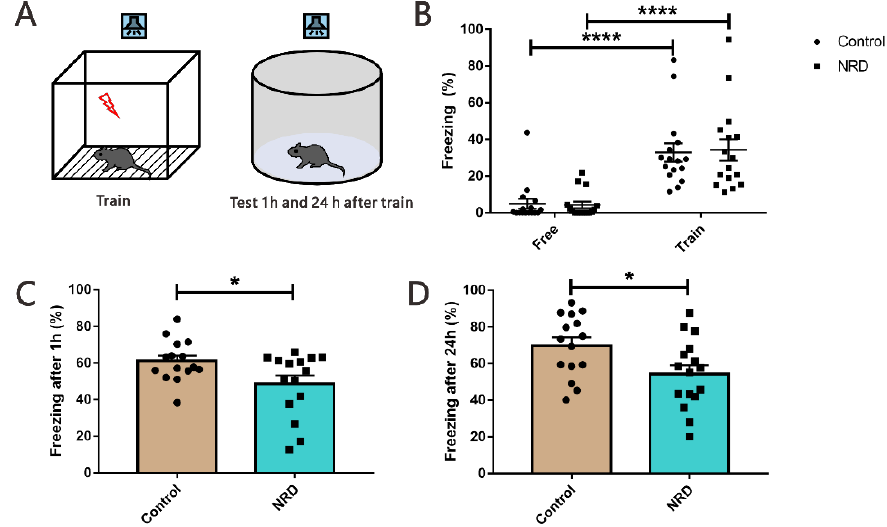
Figure 8. Reduced tone-cued fear memory in NRD mice. ( A ) Diagram of the cued fear conditioning test. ( B ) Performance of NRD mice and control mice before and during training. n (control) = 16, n (NRD) = 16. ( C ) Freezing behavior tests after 1 h of training. n (control) = 15, n (NRD) = 15. ( D ) Freezing behavior tests after 24 h of training. n (control) = 15, n (NRD) = 16. * p < 0.05, as determined by unpaired Student’s t -test; **** p < 0.0001 as determined by the two-way ANOVA. Data are expressed as the means ± SEMs.